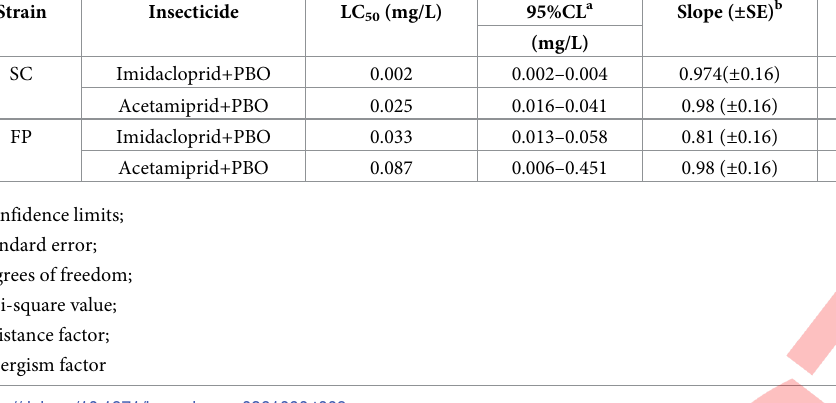
Table 3. Synergistic effect of PBO on the toxicity of imidacloprid and acetamiprid to susceptible clone (SC) and field population (FP) of M . persicae . Strain